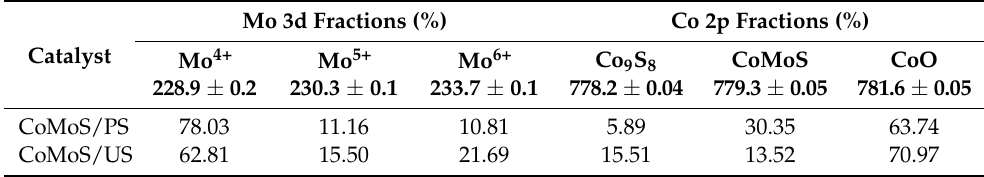
Figure 4. XPS spectra of the catalysts after sulfidation: Mo3d ( a - I ) and Co2p ( a - II ) of CoMoS/US and Mo3d ( b - I ) and Co2p ( b - II ) of CoMoS/PS. Table 3. XPS analysis results of the CoMoS